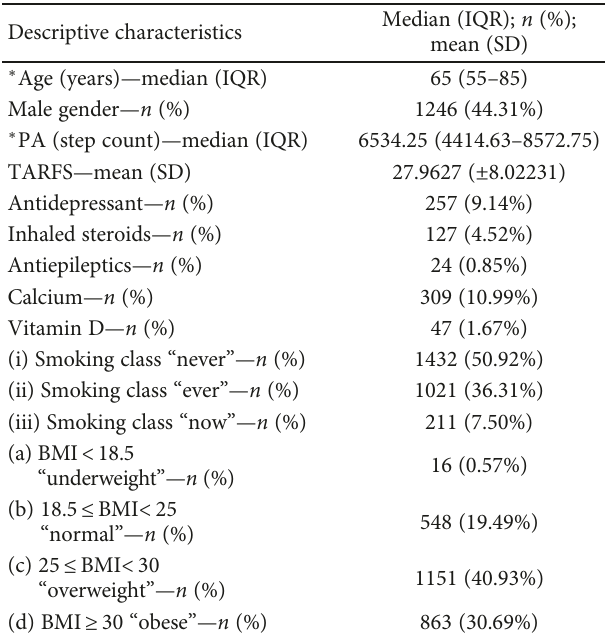
Table 4: Baseline demographic and disease-related characteristics of study population, total ( n = 2812 ).